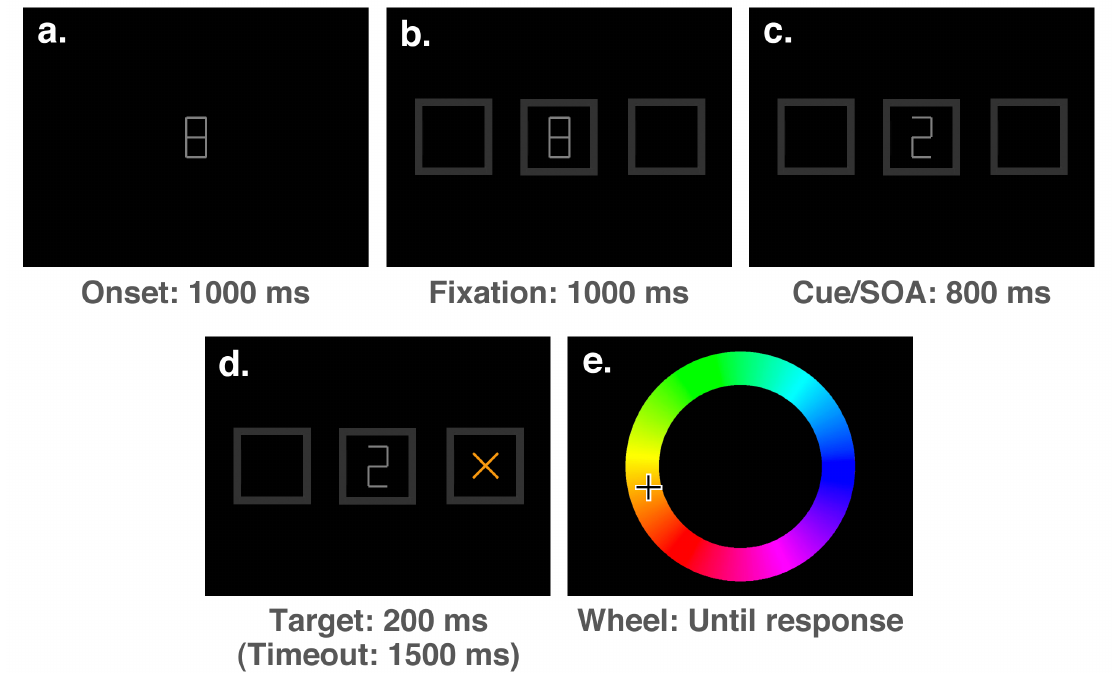
Figure 3. The sequence and duration of events during a single trial for Experiment 1. The sequence of the stimuli is indicated by the letters in the top-left corner. For the purpose of illustration, stimuli are not drawn to